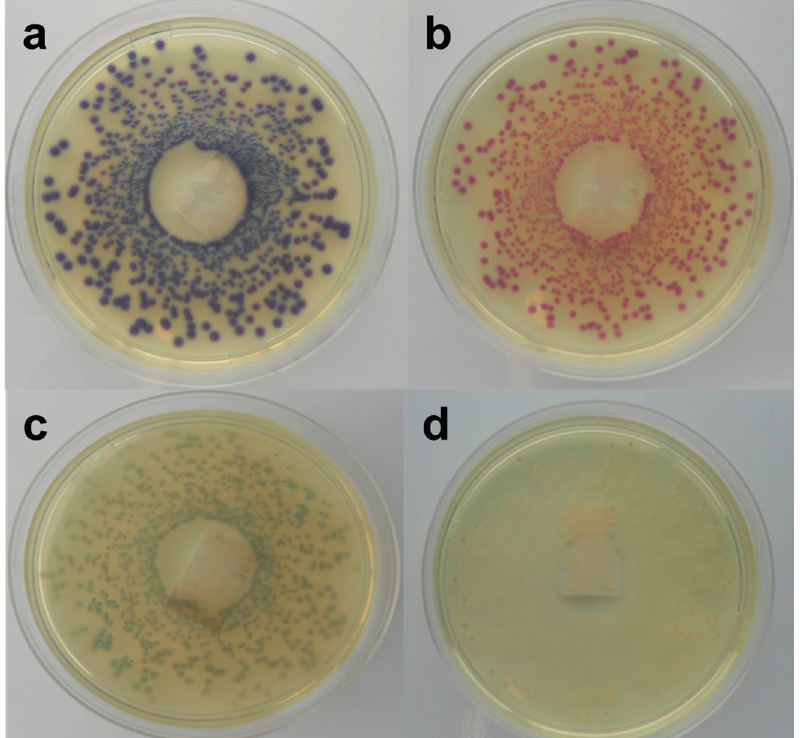
Figure 2. Macroscopic view of Rainbow O157 agar inoculated with STEC strains, ( a ) purple colonies (MB 5322), ( b ) red colonies (MB 5313), ( c ) grey-green colonies (MB 5324) and ( d ) cream-white colonies (MB